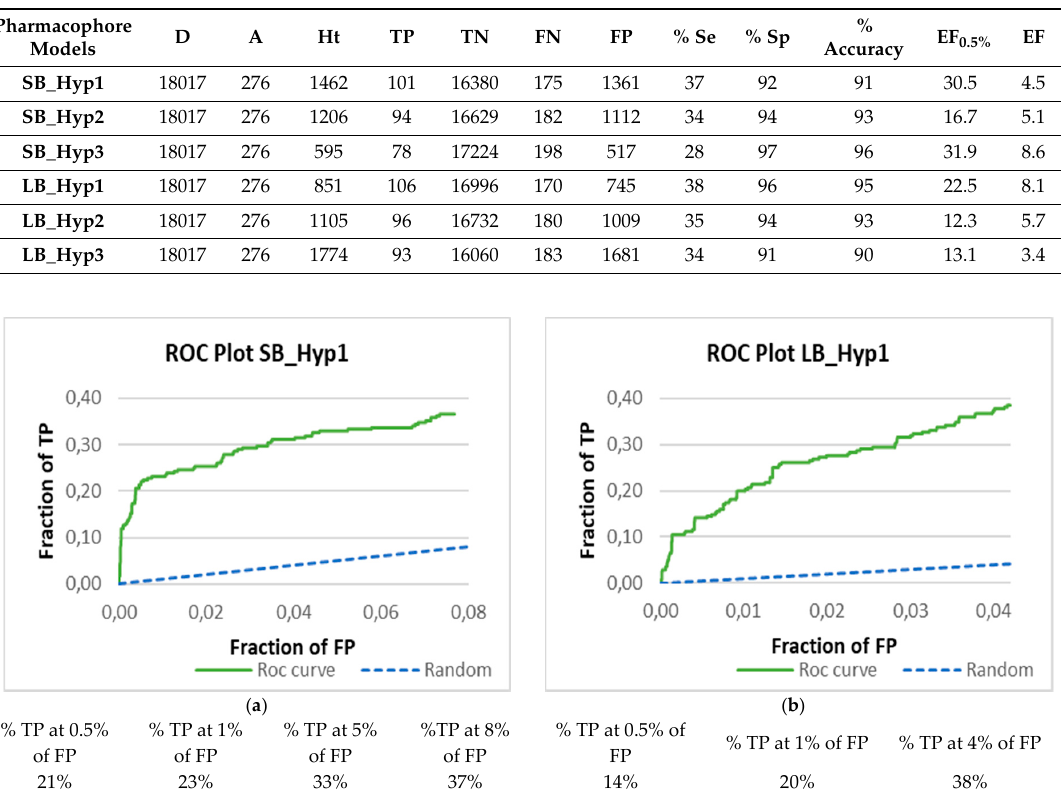
Figure 5. Receiver operating characteristic (ROC) curves and percentage of TP versus FP by the SB_Hyp1 ( a ) and LB_Hyp1 ( b ) (8% of the total database for SB_Hyp1 and 4% for LB_Hyp1). The curve only shows actives and decoys whose conformations match pharmacophoric requirements. No value is returned for molecules that do not match the pharmacophore constraints; therefore, they cannot be plotted. The green curve represents retrieval of active hits and blue is the expected performance by random guess.